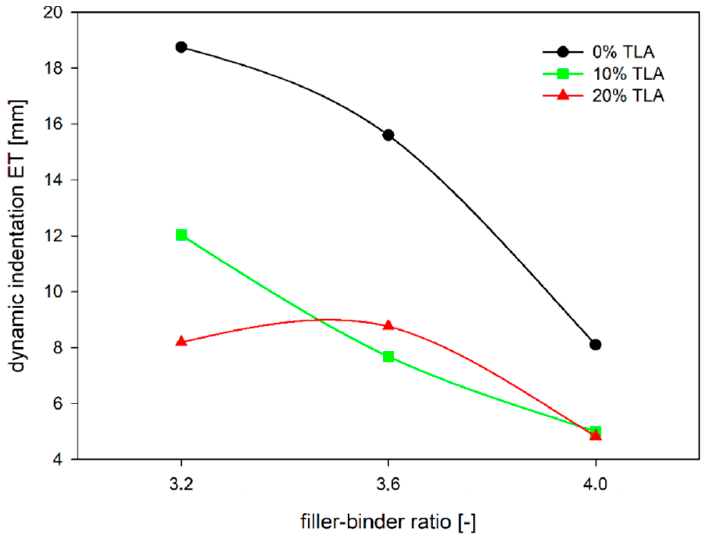
Figure 11. The dependence of dynamic indentation on the filler–binder ratio for different TLA con- tents.